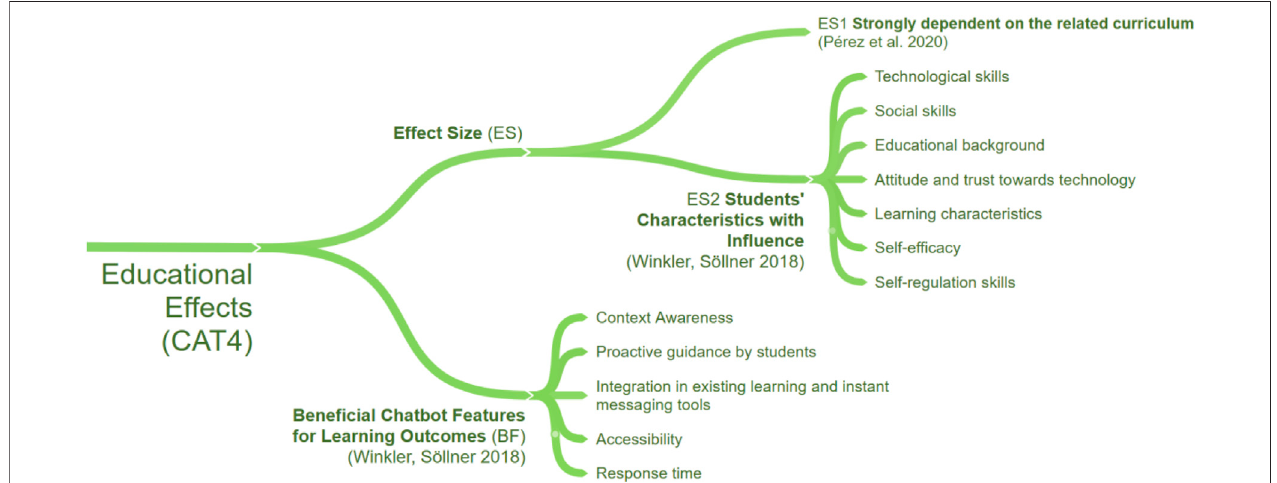
FIGURE 4 | Educational Effects of chatbots in related literature reviews